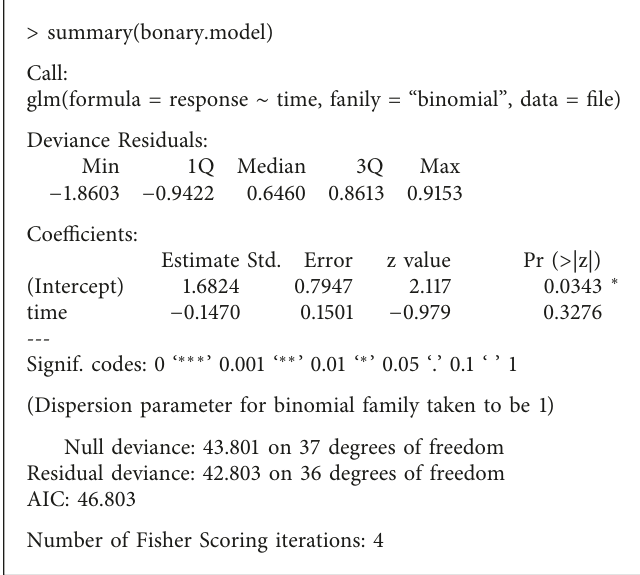
Finally, according to the responses to Question 10 (Figures 9 and 10), users believe that colours and numbers can help in defining way-finding and circulation.